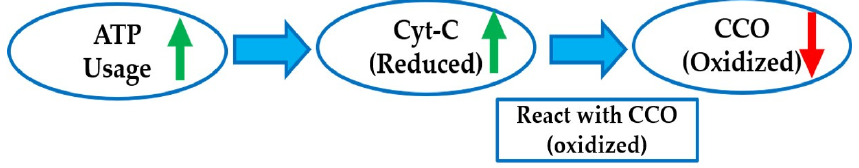
Figure 20. Hypothetical diagram showing CCO concentration change during the attention task.